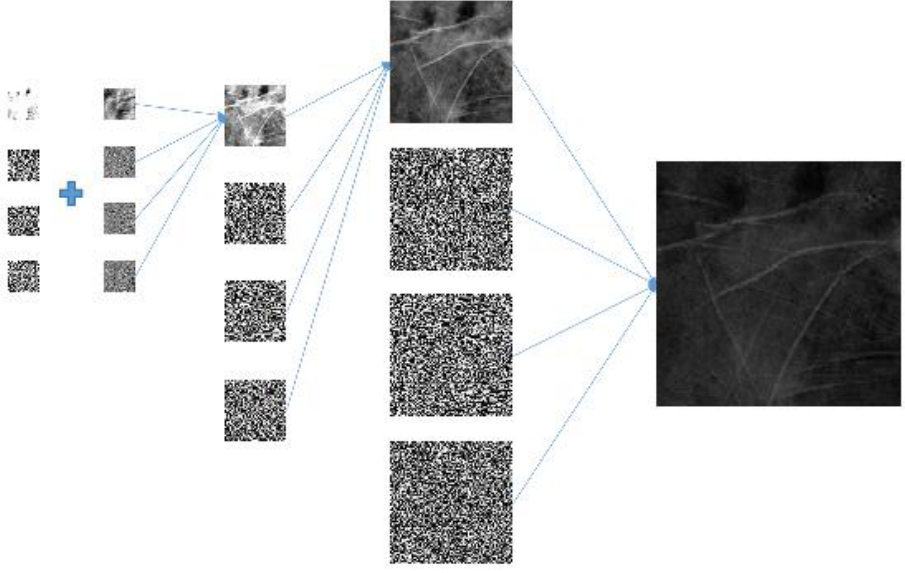
Figure 10. Three stages of IDWT fused image composition.